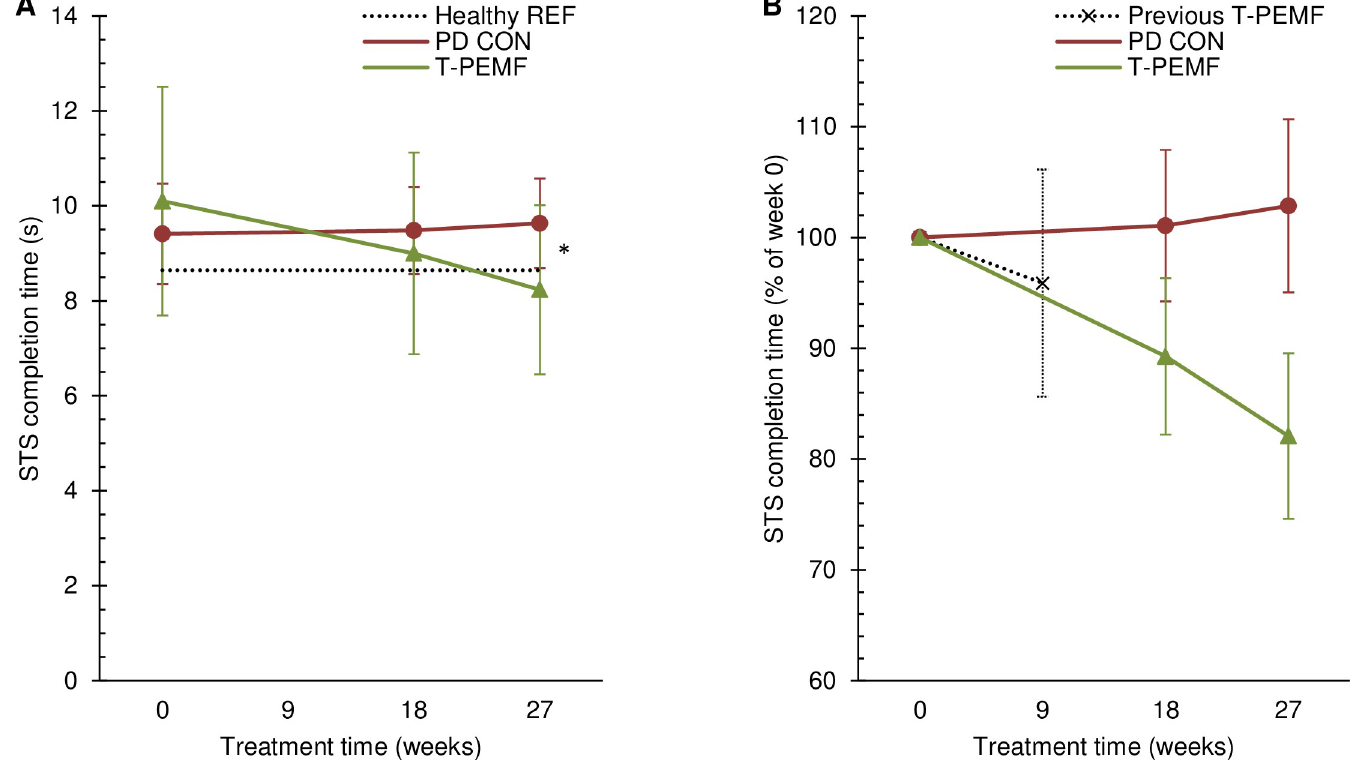
Fig 1. Sit-to-stand completion time. Absolute (A) and relative (B) completion time over the study period for the group receiving T-PEMF treatment (T-PEMF; green, solid line with triangles) and the PD control group (PD CON; red, solid line with circles). A: � Significantly different performance course over time ( P < 0.05) between T-PEMF and PD CON. Healthy reference level is indicated (Healthy REF; grey, dotted line). B: The relative change in a T-PEMF group from our previous study by Malling et al. after 8 weeks of treatment is indicated (Previous T-PEMF; black, dotted line with x’s)